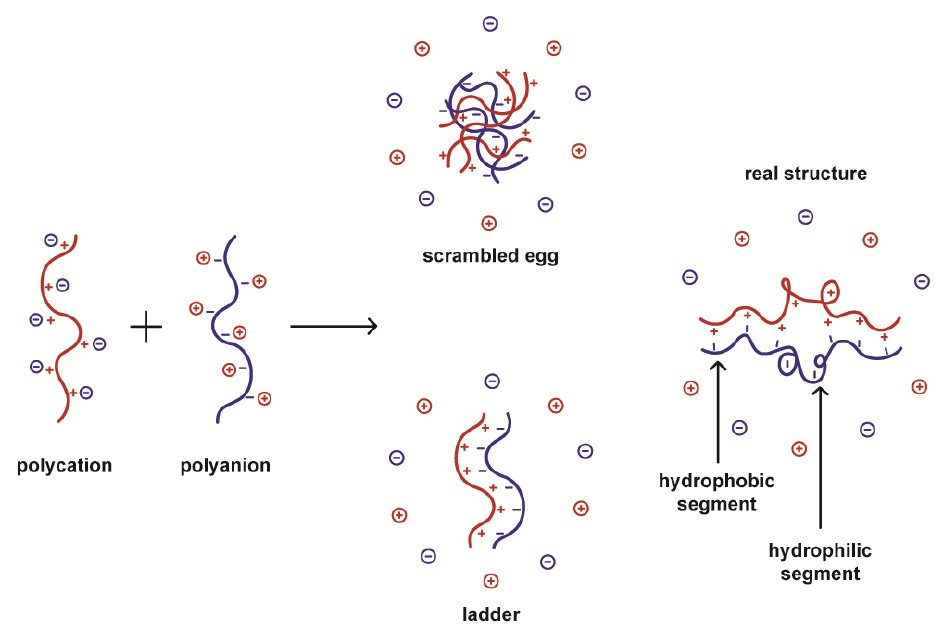
Figure 2. The structure of polyelectrolyte complexes. Scrambled egg and ladder arrangements illustrate extreme situations. The actual structure can be represented as an intermediate one combining hydrophobic ladder-like segments coexisting with disordered hydrophilic regions.